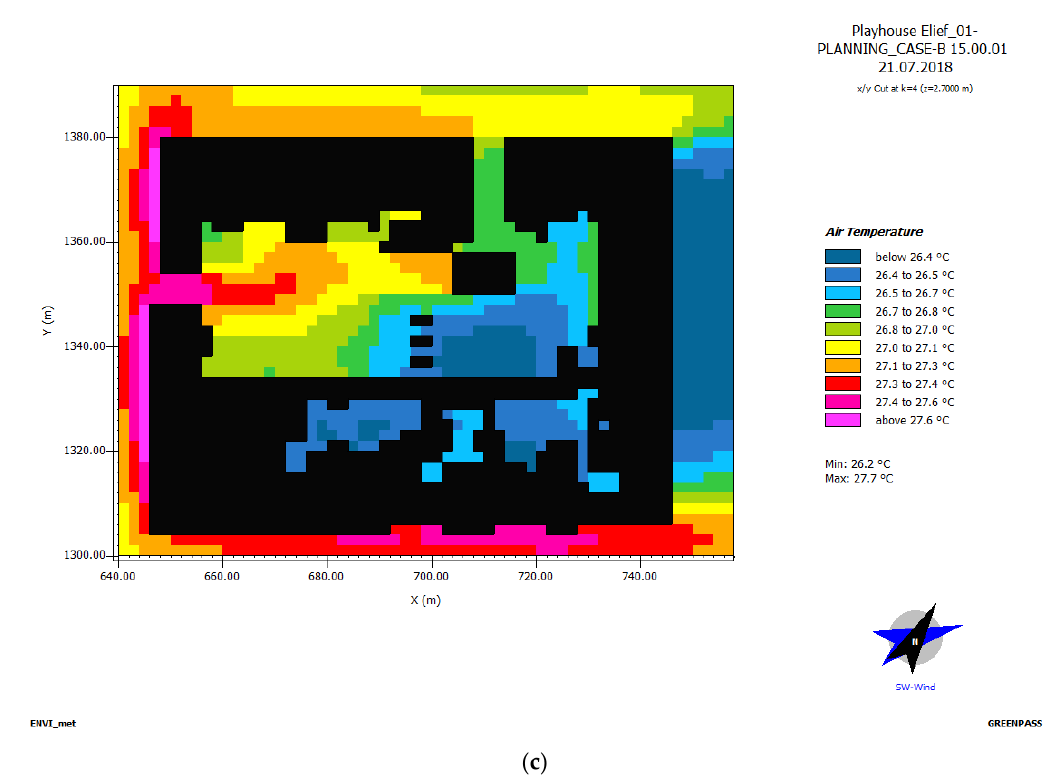
Figure 6. Results of microclimate simulation—Playhouse Elief Antwerp, comparison on a hot summer day 21.07. ( a ) Variant SQ—air temperature 15:00 at roof level; ( b ) Variant A—air temperature 15:00 at roof level; ( c ) Variant B—air temperature 15:00 at roof level .